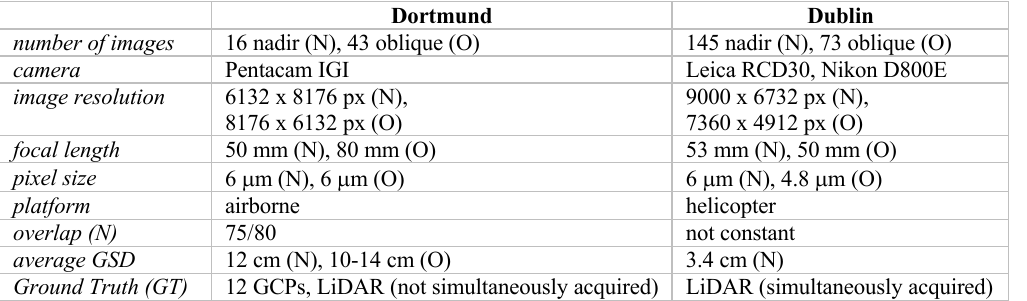
Table 1: Main characteristics of the two aerial datasets employed in this work.